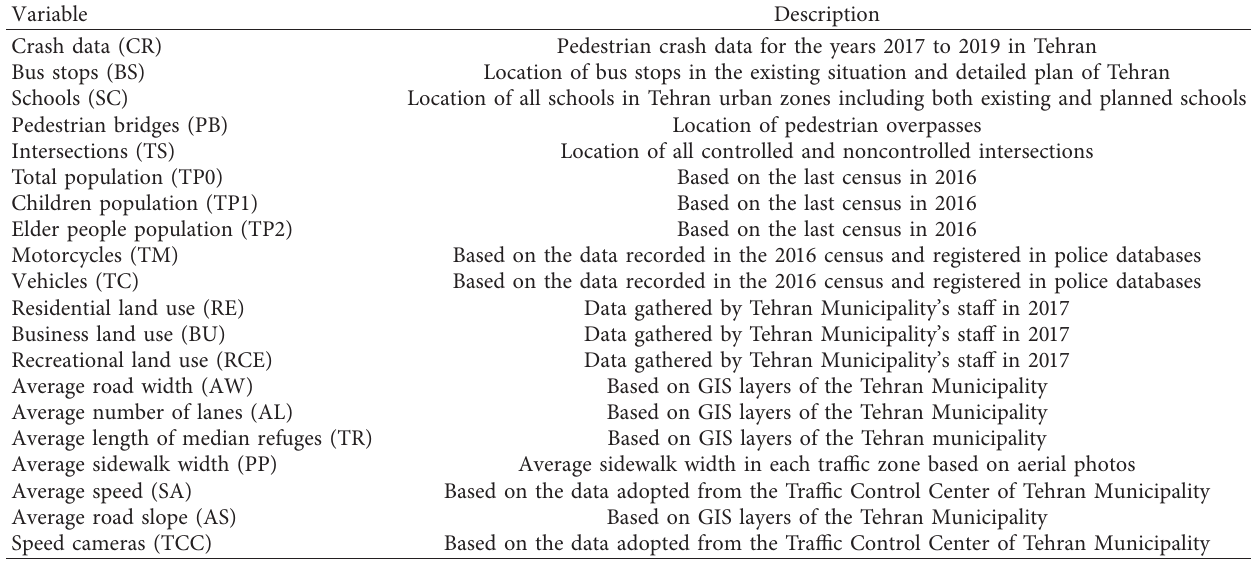
Table 1: Description of variables used in the study.